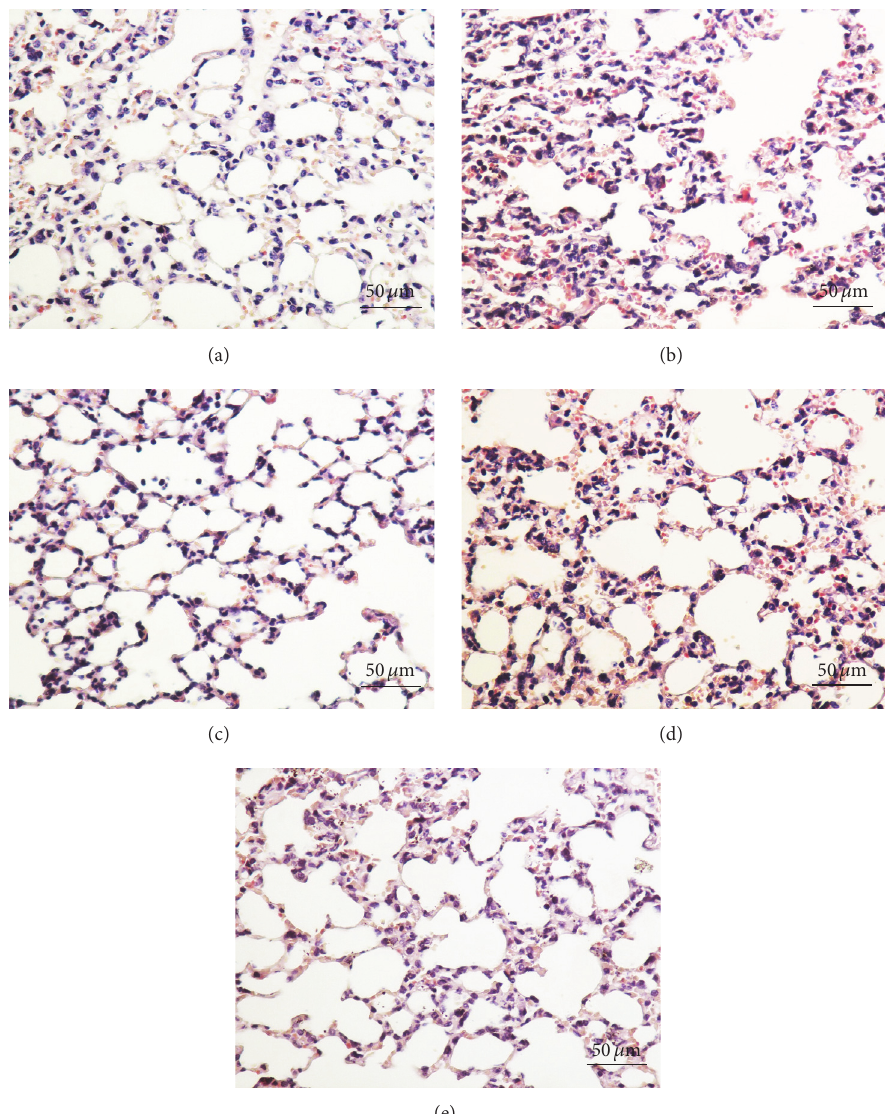
Figure 1: Effects of V. axillare on histopathological changes in lung tissues in LPS-induced ALI mice. Representative lung sections from (a) control group; (b) LPS-induced ALI model group; (c) mice injected with LPS and treated with DEX (2 mg/kg); (d and e) mice injected with LPS and given V. axillare (400 or 1200 mg/kg) are shown. Histological changes were evaluated by H&E staining and microscopy (original magnification: 200x, scale bar: 50 𝜇